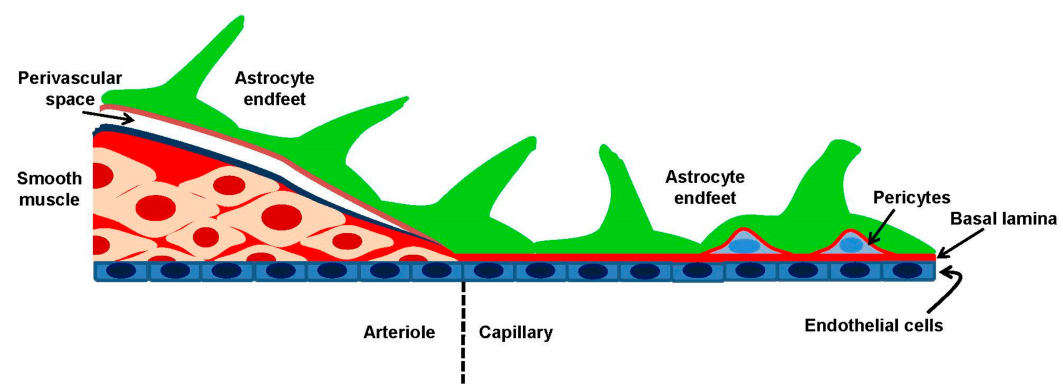
Figure 1. Cellular composition of the neurovascular unit. The vascular wall presents a different structure in arterioles and capillaries, which control the local supply of cerebral blood. Smooth muscle cells form one or more continuous layers around arterioles and change in their contractile state determine vessel diameter and regulate blood perfusion. Capillary diameter is regulated by contractile pericytes, which extend longitudinally and circumferentially along the capillary wall. Astrocyte end feet envelope arterioles and capillaries and are able to release vasoactive mediators, which regulate the contractile state of smooth muscle cells (arterioles) and pericytes (capillary) in response to neuronal